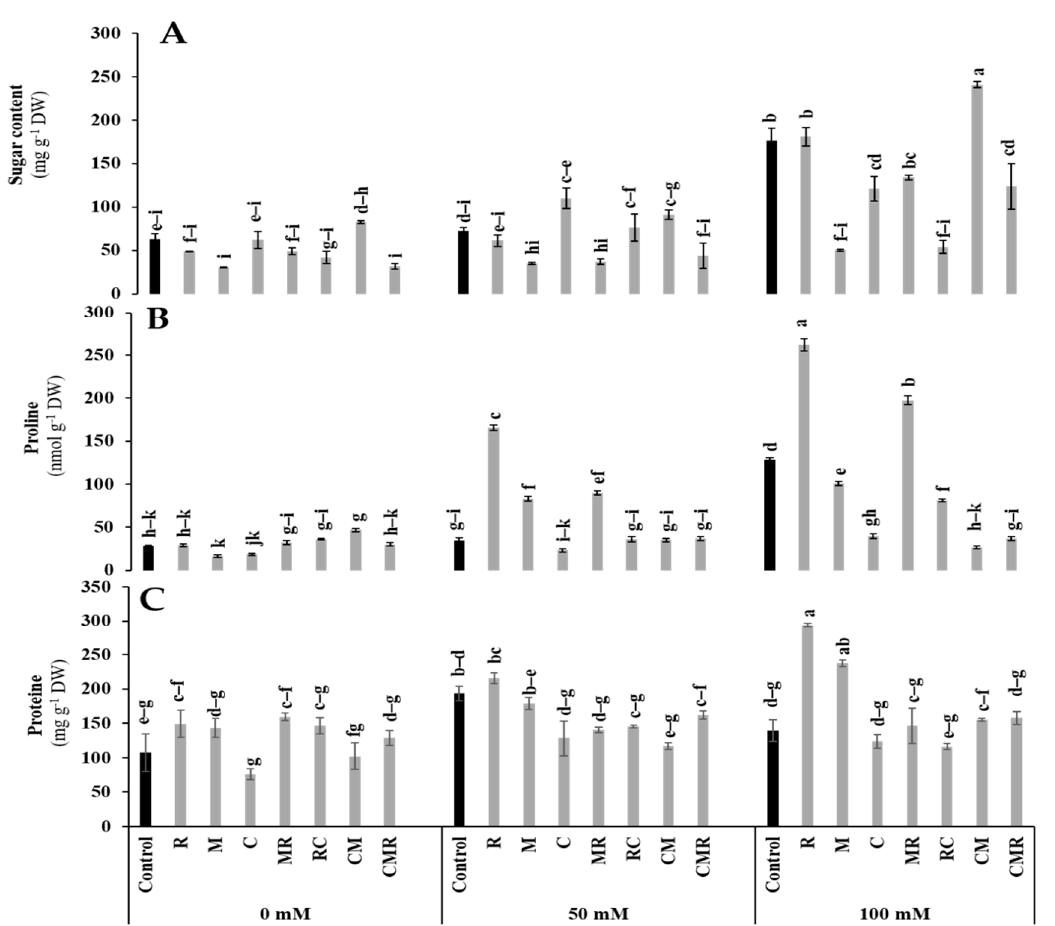
Figure 7. Impact of salt stress (0, 50, and 100 mM NaCl) on ( A ) sugar, ( B ) proline, and ( C ) proteins in lettuce subjected to different biostimulant treatments; control plants (non–amended, non–inoculated), and plants inoculated with plant growth promoting rhizobacteria (R) and/or arbuscular mycorrhizal fungi (M), and/or amended with composts (C). Means ( ± SE; 5 biological replicates) followed by the same letters are not significantly different at p < 0.05 (Tukey’s HSD).